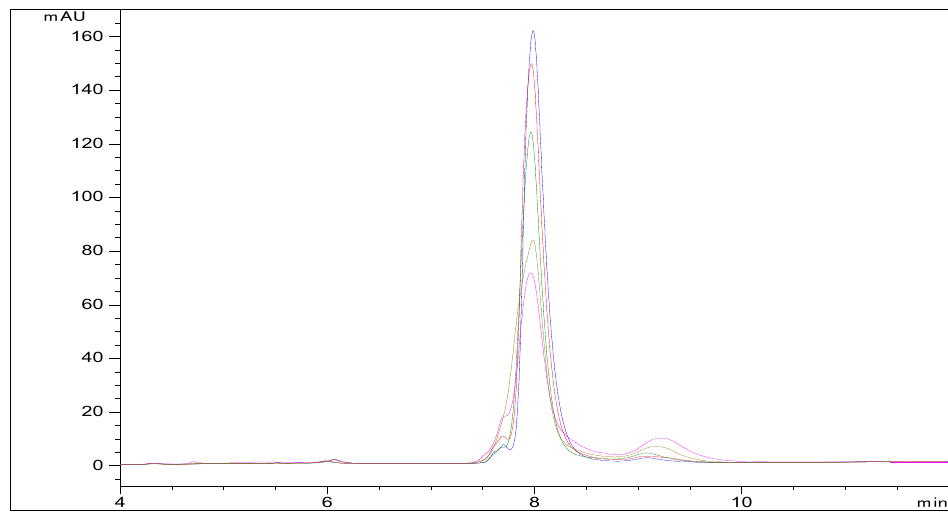
Figure A7. The effect of NaCl concentration in the mobile phase on LF peak shape (SEC column BioSep™-SEC-S 2000): −− 0.0 M NaCl, −− 0.15 M NaCl, −− 0.3 M NaCl, and −− 0.5 M NaCl. Separa- tion was performed on a BioSep™-SEC-S 2000 column at 25 °C using 0.05 M sodium phosphate buffer containing NaCl (pH 7.0) as a mobile phase at a flow rate of 0.8 mL/min).